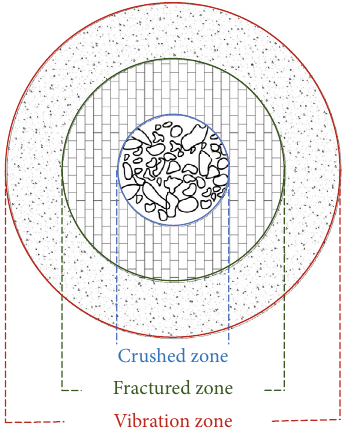
Figure 11: In fl uencing zones of deep-hole blasting [63].